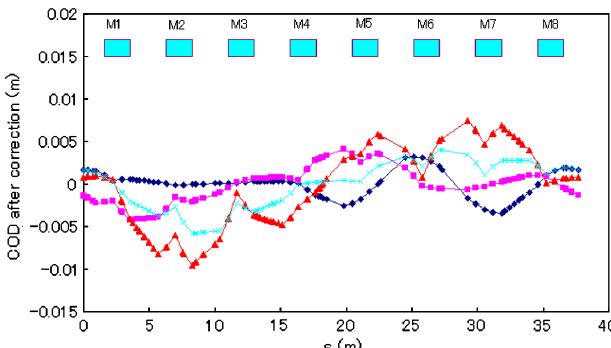
FIG. 43. Corrected CODs.